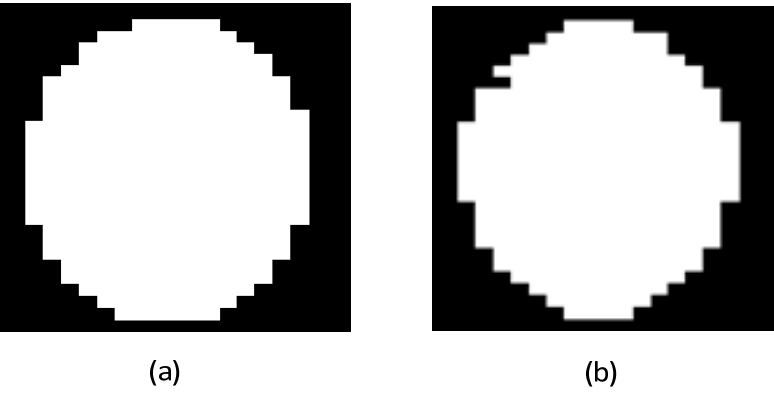
Figure 18. ( a ) The area that is judged to be packaged; ( b ) actual packaged area in the normal